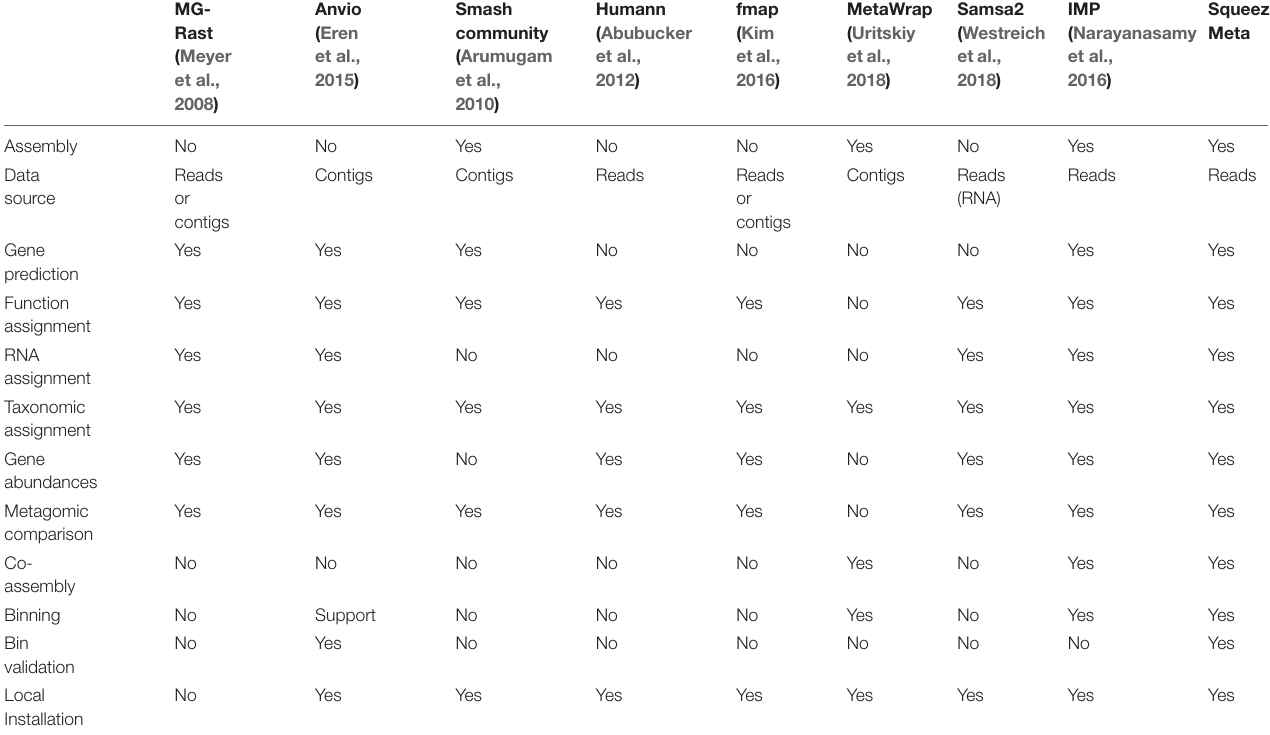
TABLE 1 | Features of different metagenomic analysis pipelines, in comparison to